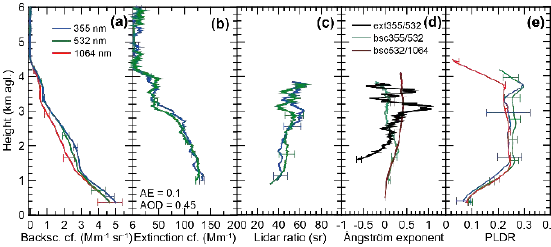
Figure 2. Optical properties captured by BERTHA (20 June 2014 23:10-02:10 UTC, 750 m smoothed). PLDR-particle linear depolarization